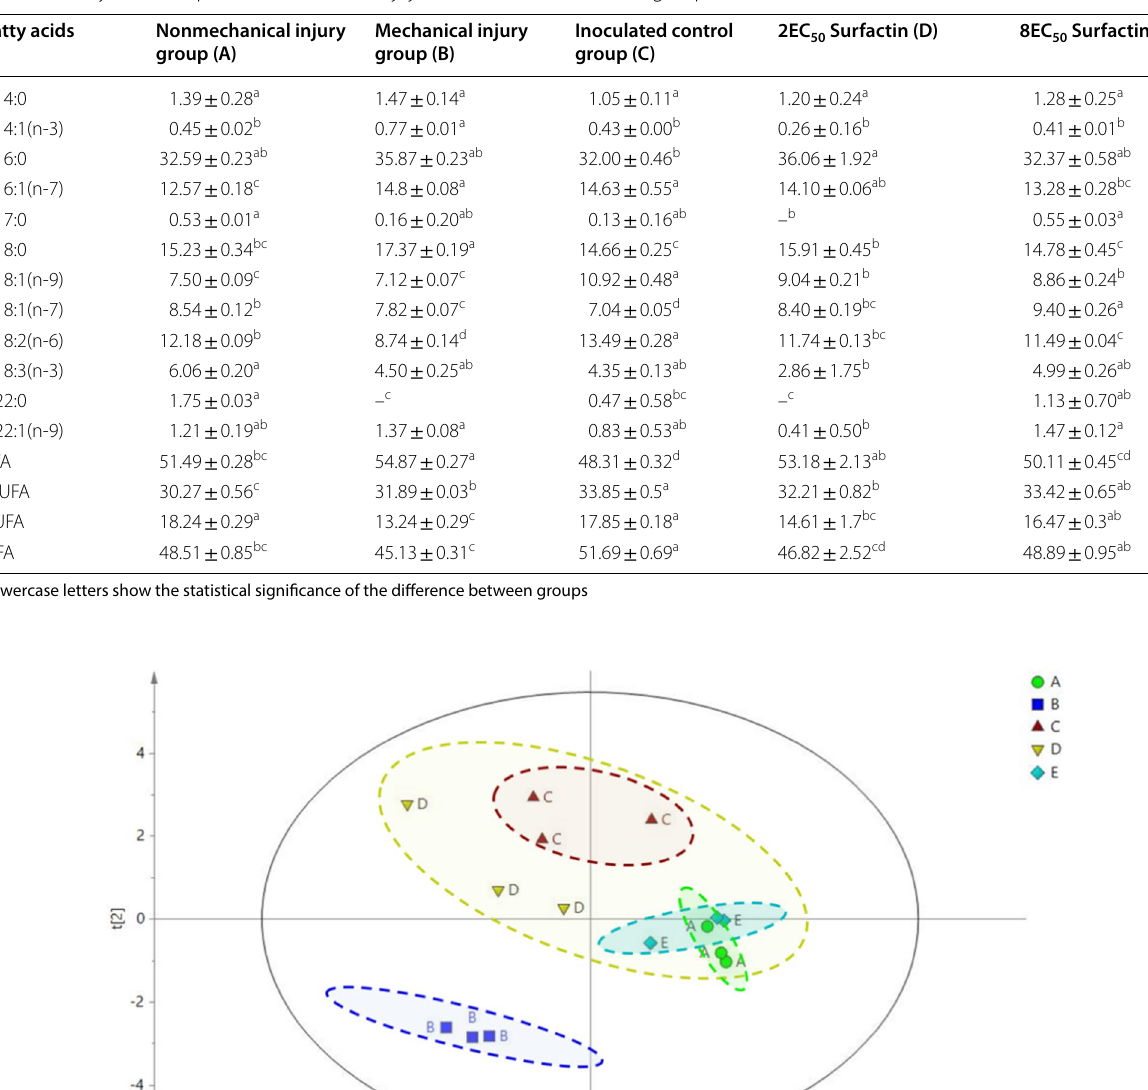
Table 1 Fatty acid composition (%) of winter jujube in different treatment groups